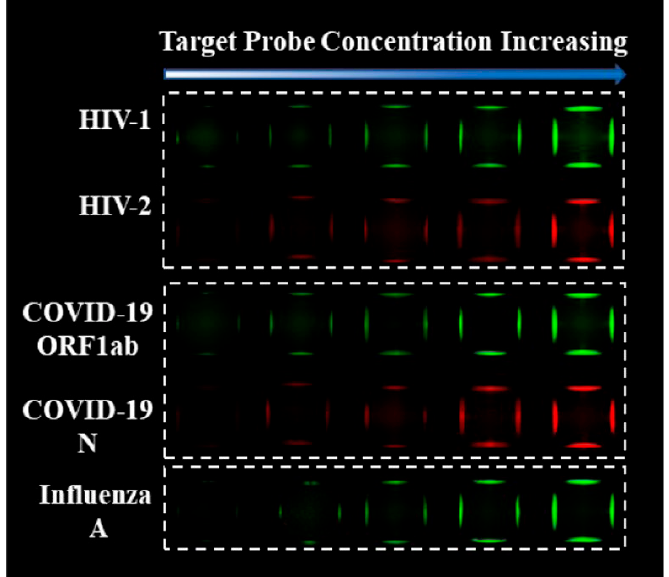
Figure 9. MoS 2 -DMA FRET sensing platform for the detection of HIV-1 and HIV-2 genes; COVID-19 ORF1ab and N genes; M genes of influenza A. Figure is reprinted with permission from Ref. [114]. Copyright American Chemical Society. (2020).